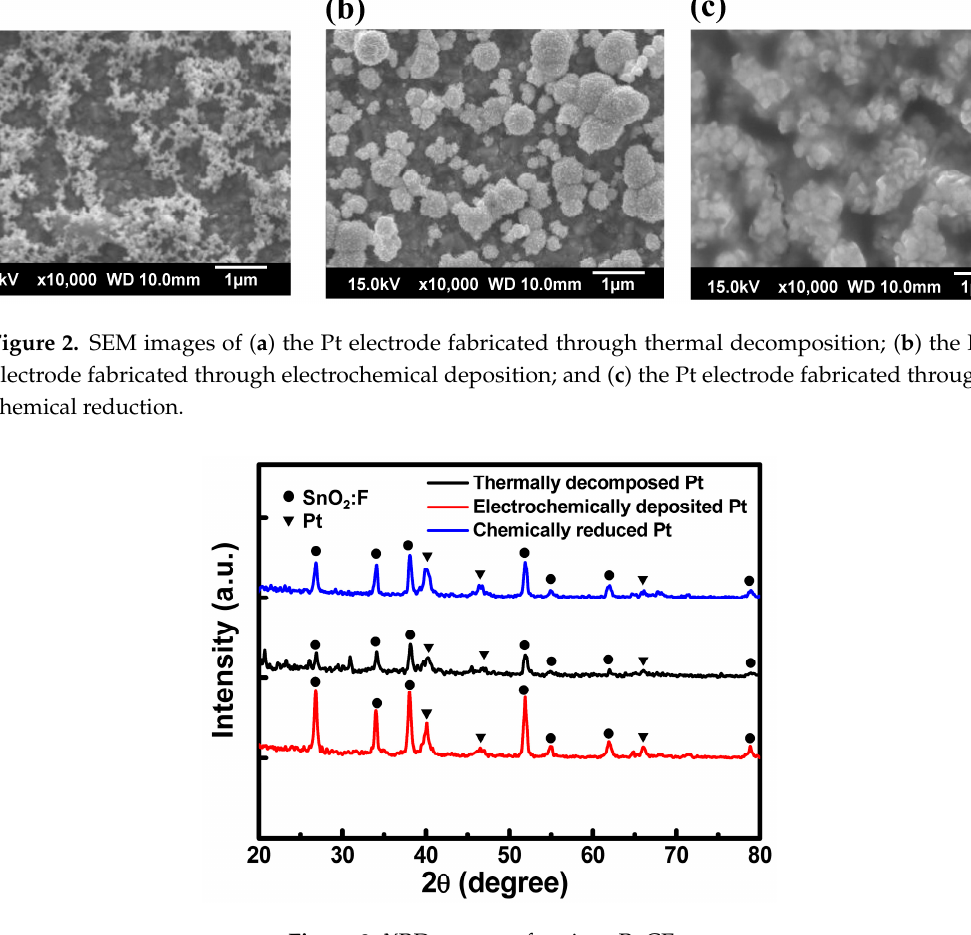
Figure 3. XRD spectra of various Pt CEs.